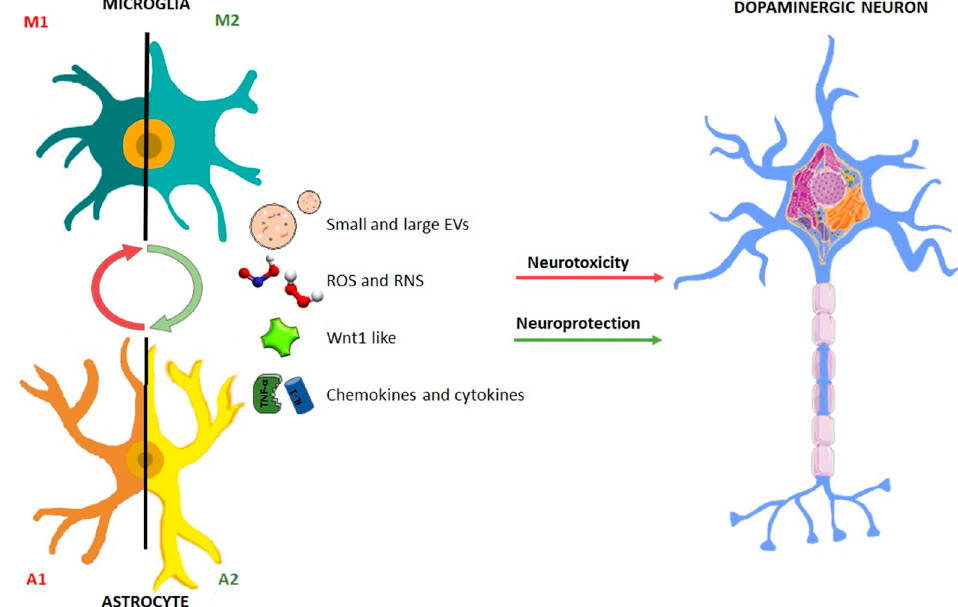
Figure 1. Dual role of glial cells in the regulation of the balance between neurotoxicity and neuroprotection in Parkinson’s disease. Astrocyte and microglial schematic drawing illustrating the dual facet of glial cells. Upon basal ganglia injury, glial cells acquire an activated “harmful” so-called astrocyte (A1) and microglial (M1) phenotype, characterized by up-regulated release of a number of pro-inflammatory mediators, including cytokines and chemokines, associated by generation of elevated levels of reactive oxygen (ROS) and nitrogen species (RNS), in turn generating a vicious cycle of inflammation and dopaminergic degeneration. Glial cells are also endowed with neuroprotective factors, including Wnt1, that incite neuroprotection and repair of the dysfunctional neurons. The potential glia-glia and glia-neuron crosstalk via small and large vesicles is illustrated (for detail, see the text).